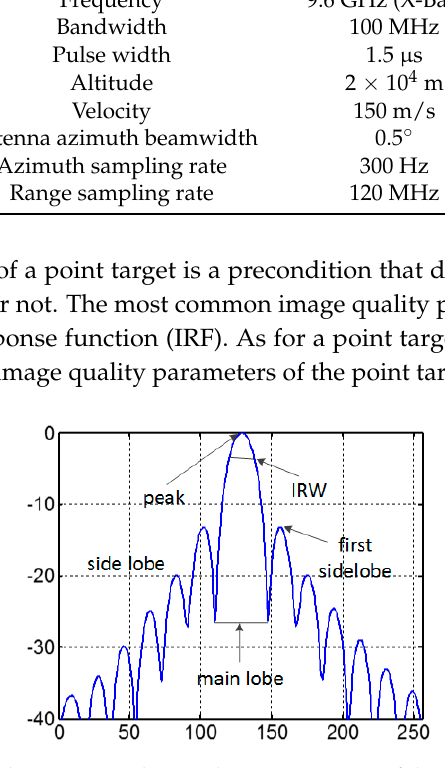
Figure 13. The image quality analysis parameters of the point target.